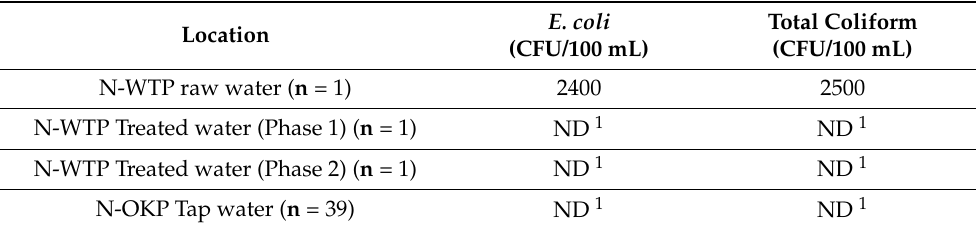
Table 5. E. coli and total coliform (CFU/100 mL) in chlorinated